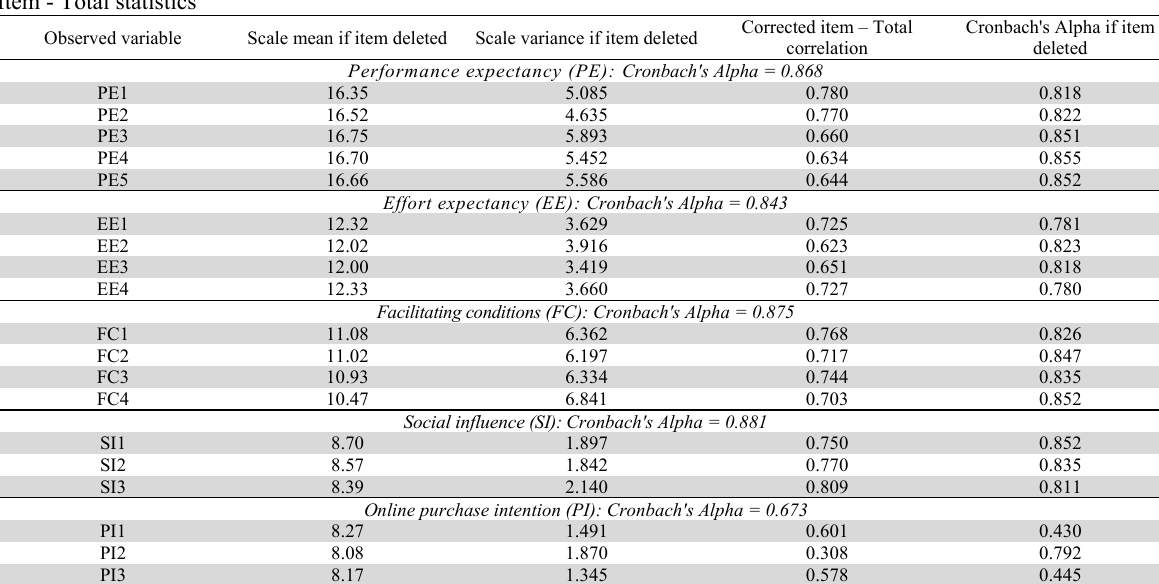
Item - Total statistics Observed